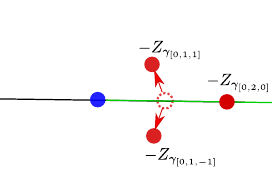
Figure 13 . Zoom in around the real axis. The dashed circle represents the singularities from the 2 hypermultiplets with − Z = − Z in massless case. Changing from (7.6) to C inst γ [0 , 1 , 1] γ [0 , 1 , − 1] corresponds to split the dashed circle into two red dots representing the singularities at − Z and the − Z . The green ray represents ϑ = 0 . γ [0 , 1 , 1]